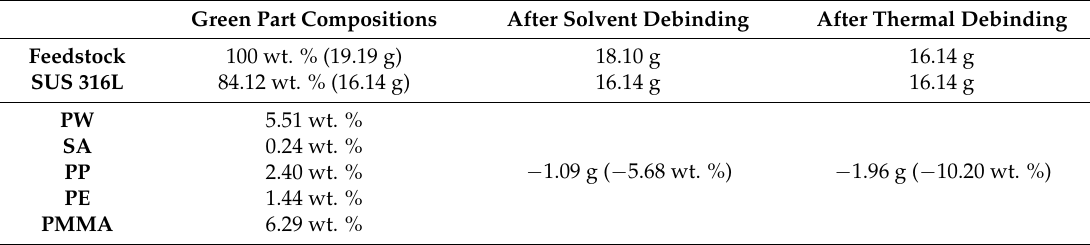
Table 8. Weight loss analysis of the tensile specimen during the debinding process.